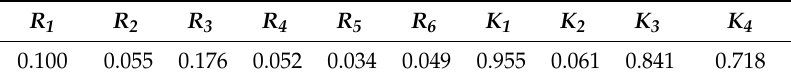
Table 3. Thermal parameters of the investigated camera